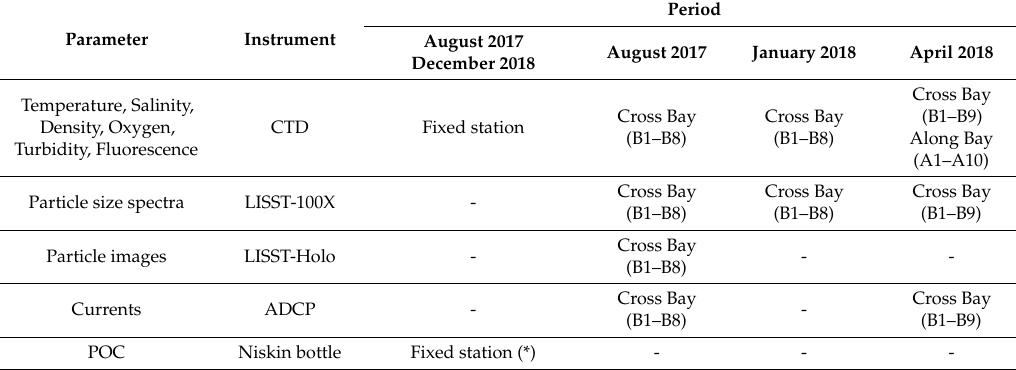
Table 1. List of parameters collected at the fixed station and along the sections. (*) monthly